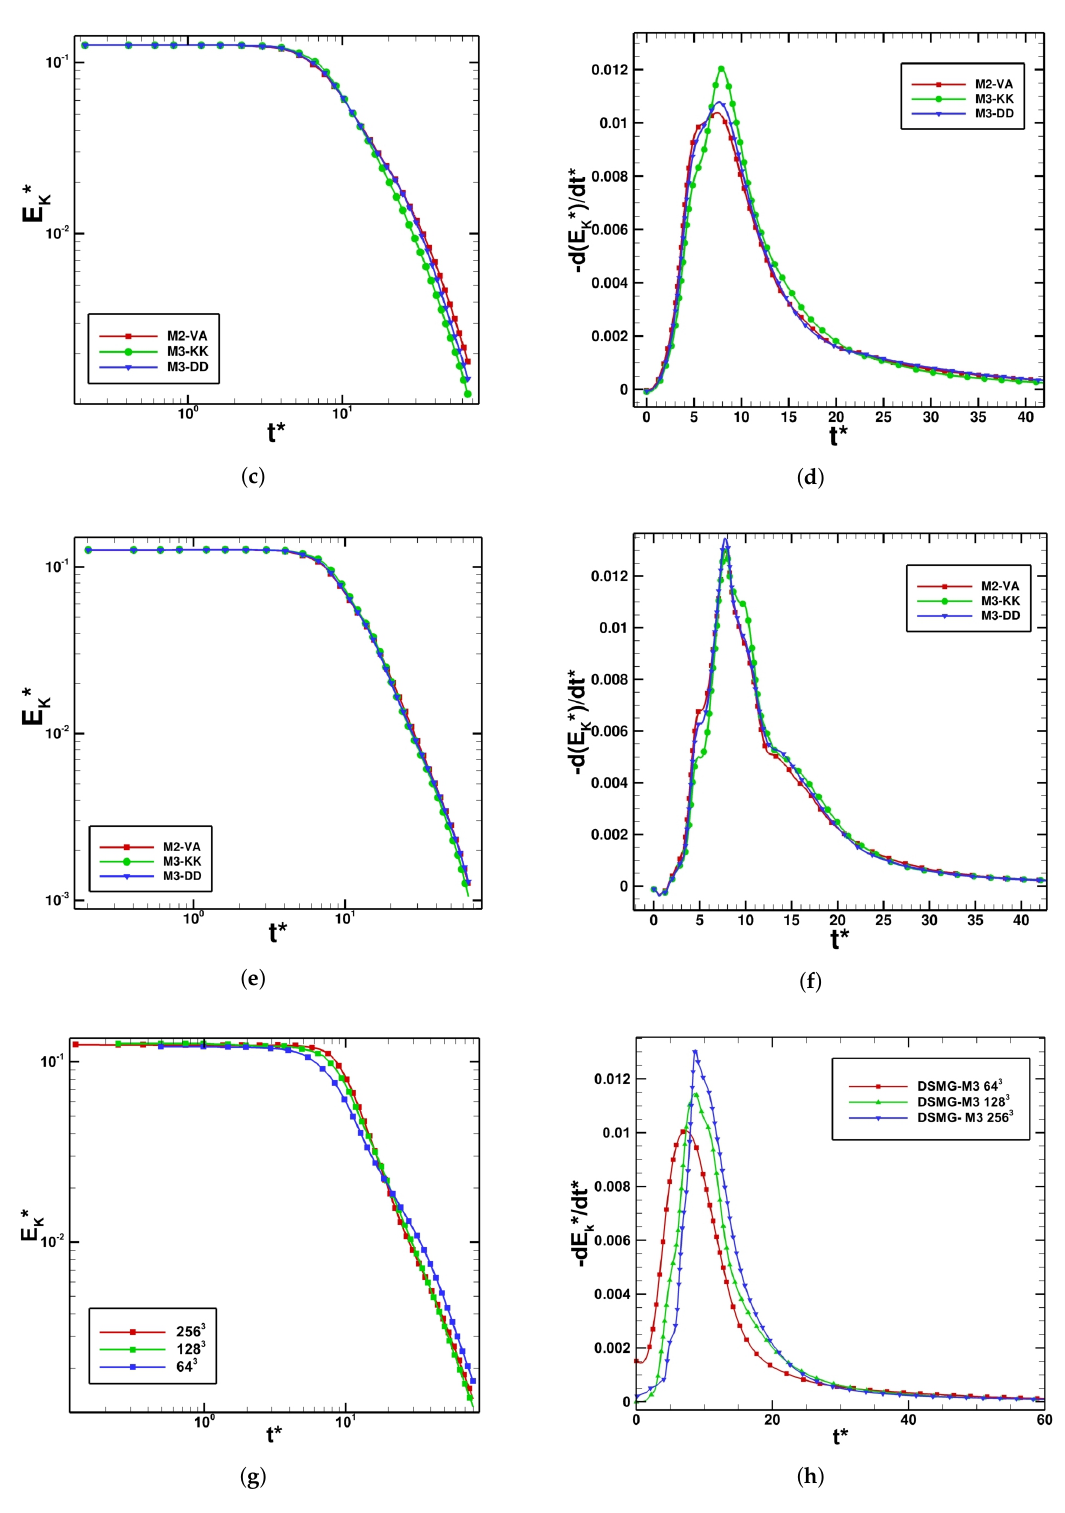
Figure 3. Evolution of the volumetrically-averaged kinetic energy represented in logarithmic scale and kinetic energy dissipation obtained on 43 3 , 64 3 and 96 3 grids for the ILES approach and 64 3 , 128 3 and 256 3 for the LES approach. ( a ) ILES, E ∗ ( d ) ILES, − dE ∗ / dt ∗ (64 3 ); ( e ) ILES, E ∗ K